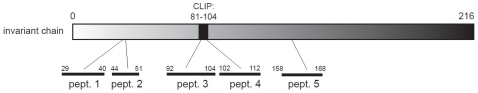
Invariant chain-derived peptides identified in isolated HLA-I molecules of B-LCLs.Peptide elutions of purified HLA-I molecules from EBV-transformed B-LCLs resulted in the identification of five peptides originating from the invariant chain. HLA-I purification and subsequent mass spectrometry analysis are described in Materials and Methods. Of note, peptide 3 and 4 are located in the CLIP region, known for universal binding to HLA-II molecules.